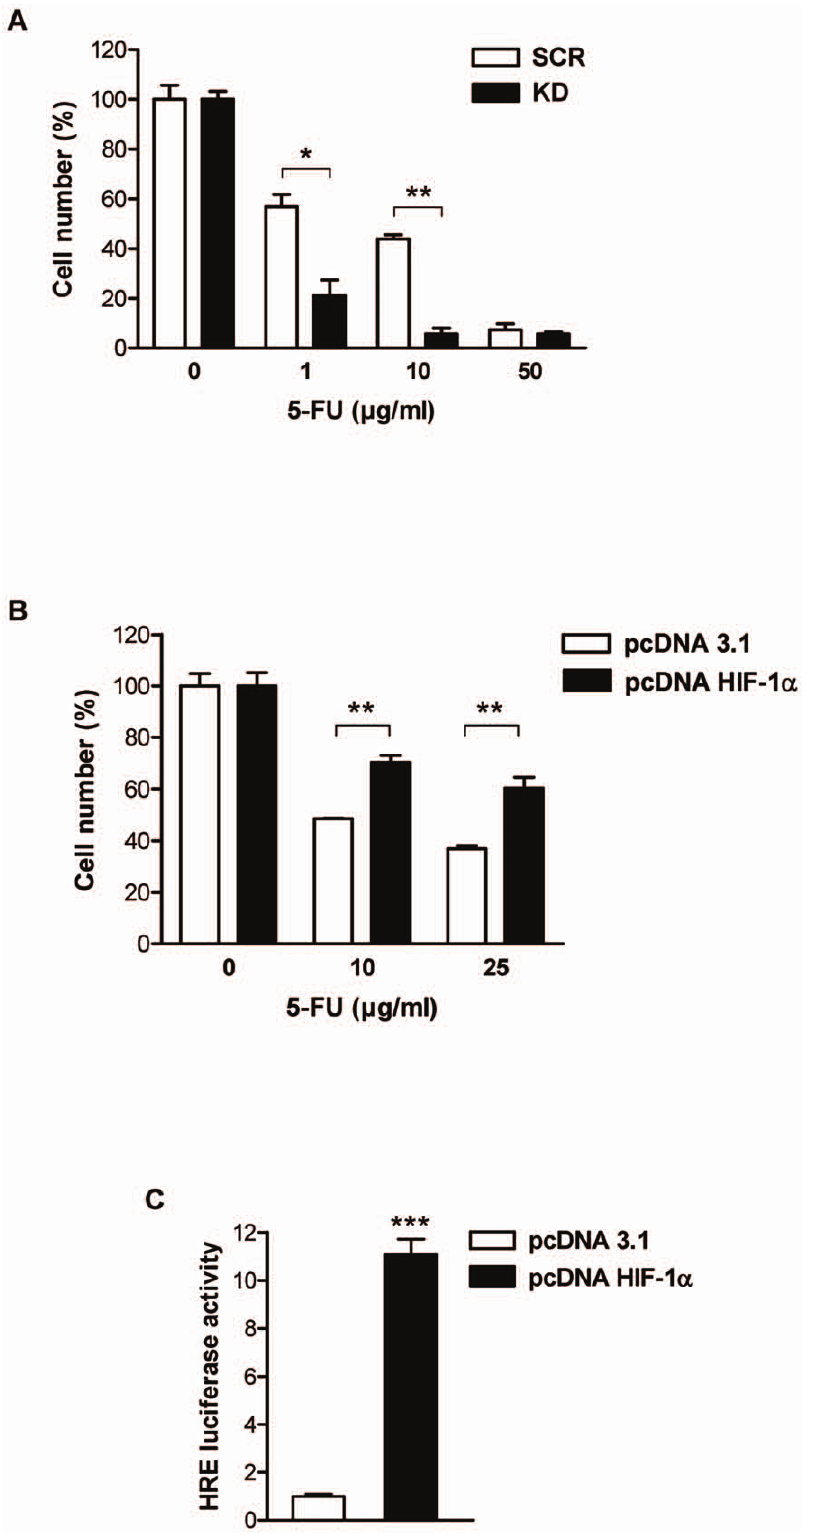
Figure 1. HIF-1 a mediates resistance towards the chemotherapeutic agent 5-FU in AGS cells. (A) Proliferation of AGS KD and SCR cells 24 h after treatment with increasing concentrations of 5-FU under normoxic conditions. Cell numbers are shown as percent of untreated cells (*, P , 0.05; **, P , 0.01). (B) AGS wild-type cells were transfected with HIF-1 a expression vector (pcDNA HIF-1 a ) or empty vector (pcDNA 3.1) and treated with 5-FU 24 h post transfection. Cell numbers were determined 24 h after treatment with 5-FU, and are shown as percent of untreated control cells (**, P , 0.01). (C) AGS wild-type cells were co-transfected with either pcDNA HIF-1 a or pcDNA 3.1 plus HRE-Luciferase reporter (pHRE-Luc) and Renilla reporter (phRL-null) as internal control. Cells were harvested 48 h post transfection. HRE luciferase activity, normalised for Renilla luciferase activity, was expressed relative to that of control transfected cells (***, P , 0.001).